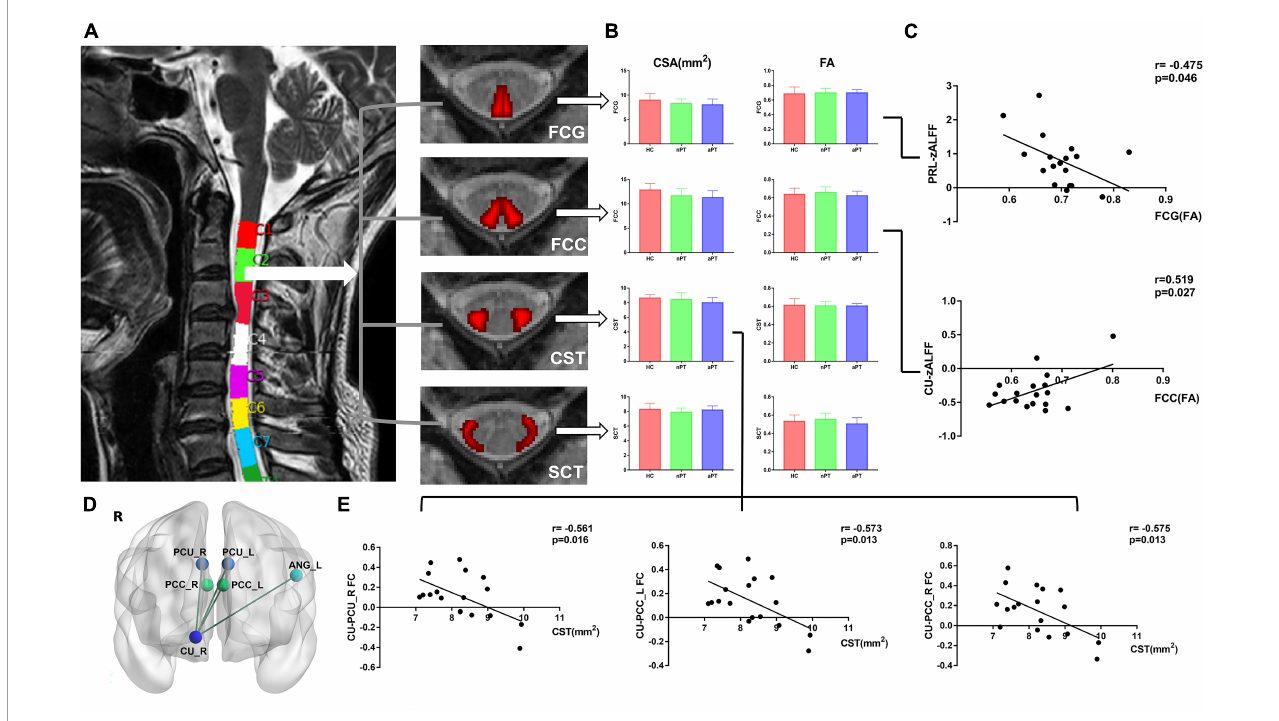
FIGURE3 Comparison of spinal tracts and the relationship between fractional anisotropy (FA), cross-sectional area (CSA), z-score transformation amplitude of low-frequency fluctuations (zALFF) value and caudate connectivity. (A) The CSA and FA values of paired FCG, FCC, CST, and SCT at the C2 level were computed by the Spinal Cord Toolbox. (B) One-way analysis of variance with Bonferroni post-hoc test was preformed and no significant difference in the FA value or CSA of these tracts at the C2 level was noted between the HC, nPT, and aPT groups. (C) The zALFF of PRL was negatively correlated with the FA value of FCG and the zALFF of CU was positively correlated with the FA value of FCC. (D) FC between the right CU and left ANG, bilateral PCU, and bilateral PCC was extracted. (E) The CSA of the CST at C2 level was negatively correlated with the FC between the right CU and right PCU and bilateral